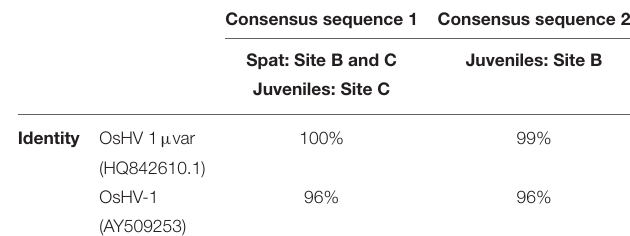
TABLE 2 | Consensus sequences generated by sequencing of positive samples and their percentage of identity to previous annotated genotypes based on BlastN local searches.